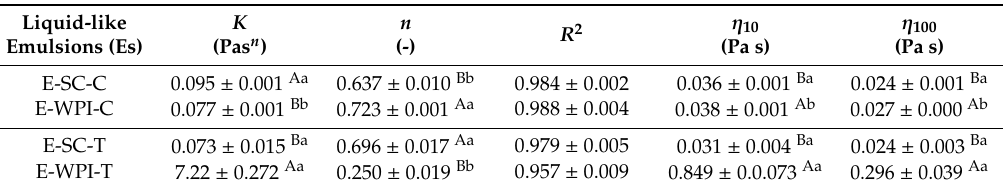
Table 1. E ff ect of emulsifying protein (EP) and condensed tannins (T) on the steady shear rheological properties of liquid-like emulsions